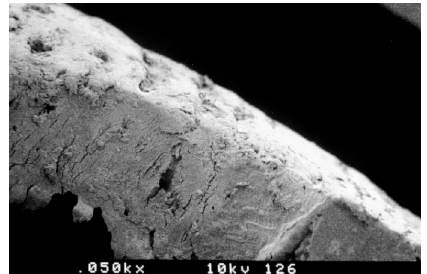
Figure 3. SEM analysis of ultrasonic implant site preparation. Bone surfaces appeared slightly roughened by piezoelectric preparation. No smear layer, bone fragments or biologic material were seen over bone walls, and the bone vascular canals appeared clean and open, including the haversian canals and the few small medullary spaces of the cortical bone.